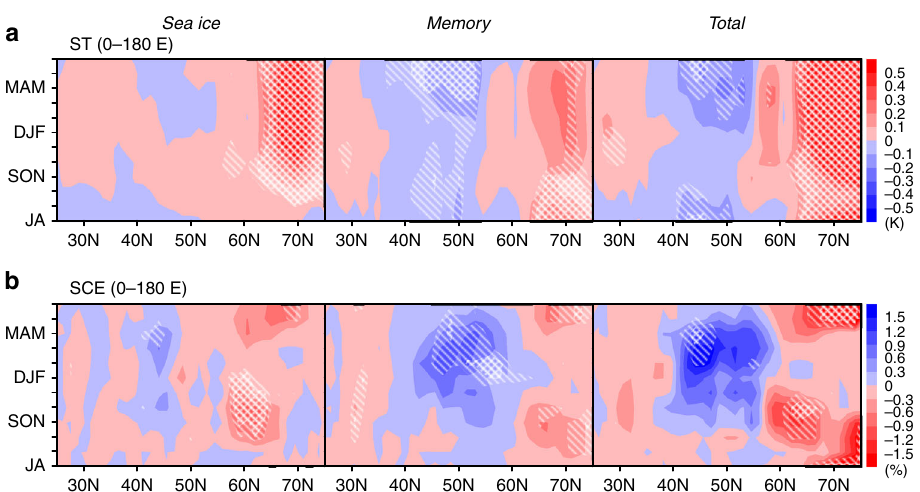
Fig. 5 Anomalies of land process over the Eurasian continent. Annual evolution of 3-month mean anomalies of a soil temperature (ST) average from the surface to 4 m depth and b snow cover extent (SCE) over the Eurasian continent (0 – 180°E). From left to the right, panels show 100-year averages of sea ice, memory, and total effects, respectively. Red and blue colors are de fi ned in the legend at the right of each panel. Hatched and double-hatched areas indicate statistical signi fi cance exceeding 95 and 99%, respectively